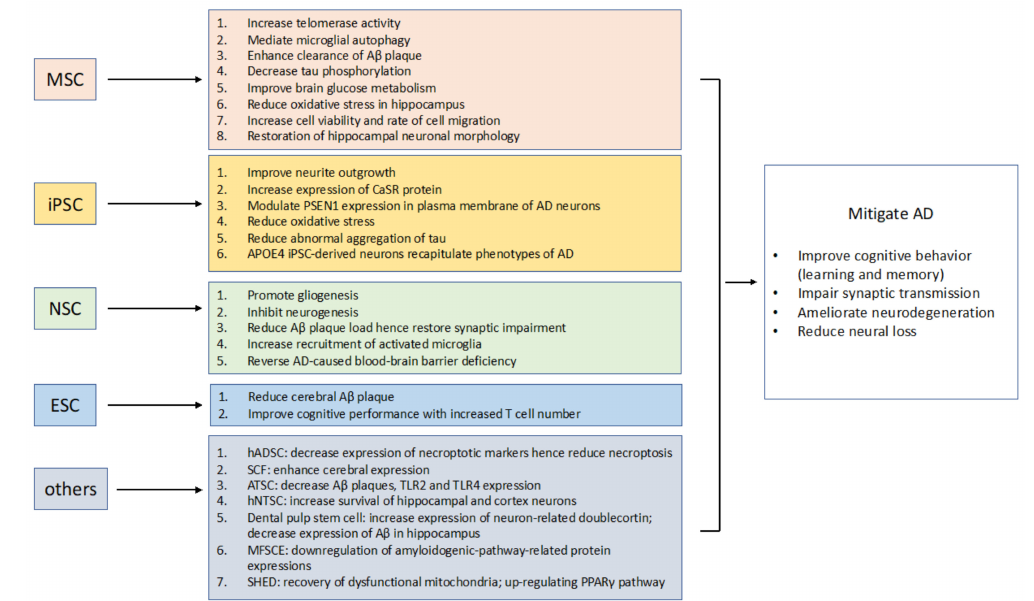
Figure 3. Collection of pathological effects for different types of stem cells. Abbreviations: MSC (mes- enchymal stem cell), NSC (neural stem cell), iPSC (induced pluripotent stem cell), ESC (embryonic stem cell), SHED (stem cell from human exfoliated deciduous teeth), SCF (stem cell factor), ATSC (adipose tissue mesenchymal stem cell), hADSC (human adipose-derived stem cell), hNTSC (human neural crest-derived nasal turbinate stem cell), MFSCE (membrane-free stem